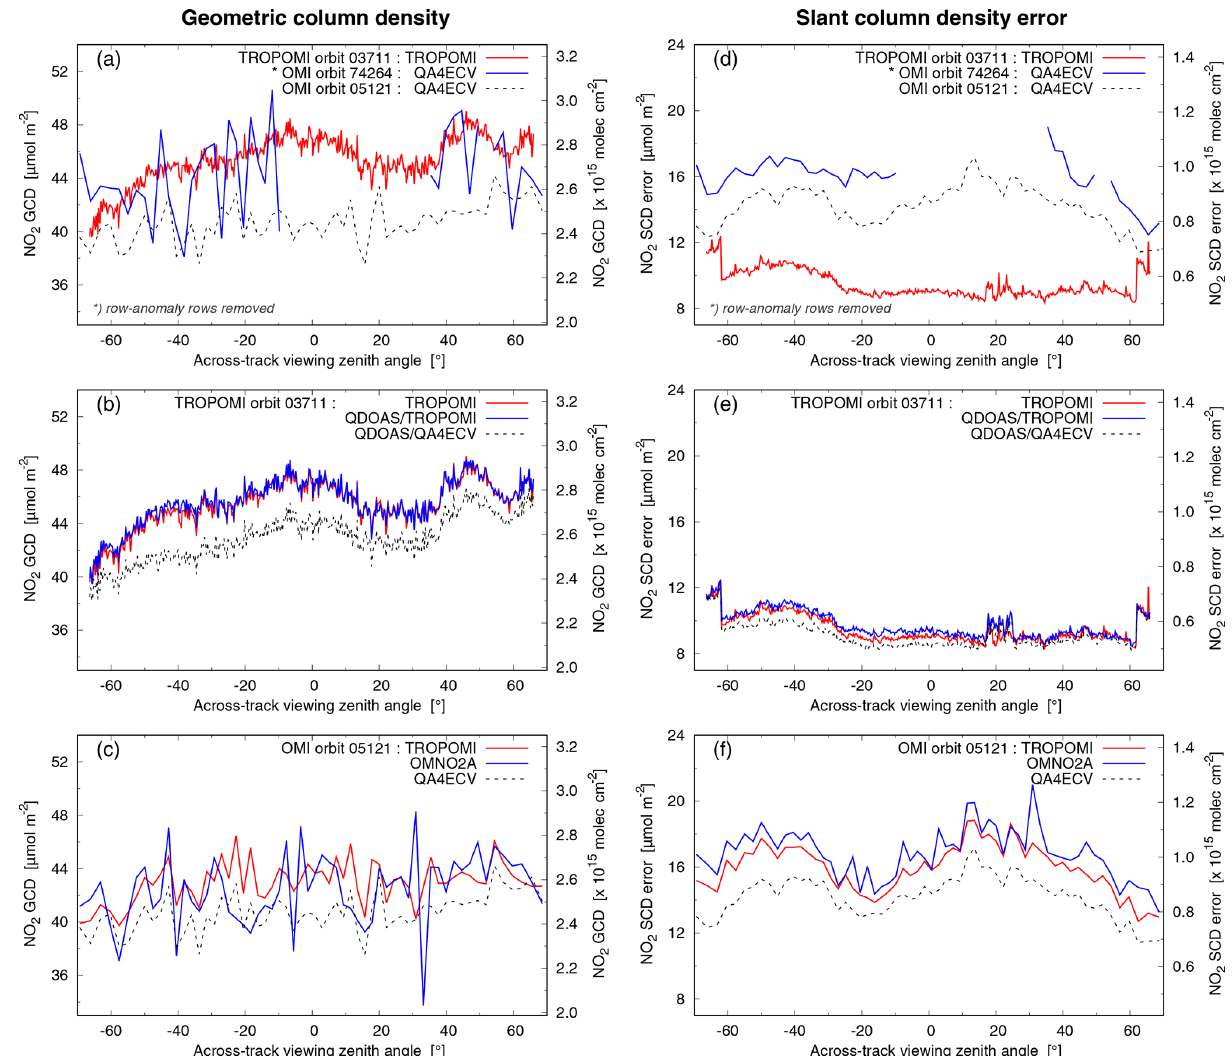
Figure 3. NO 2 geometric column density (GCD, defined in Sect. 4; a, b, c ) and slant column density (SCD) error estimate from the DOAS fit (d, e, f) averaged over the TL range as function of the across-track viewing zenith angle ( θ ) of Pacific Ocean orbits of TROPOMI and OMI on 1 July 2018 and of OMI on 1 July 2005. (a, d) Regular TROPOMI processing of TROPOMI compared with OMI–QA4ECV processing. (b, e) Regular TROPOMI processing of TROPOMI compared with QDOAS processing with TROPOMI settings and with QA4ECV settings. (c, f) Regular TROPOMI processing of OMI compared with OMI–QA4ECV and OMNO2A (v2)